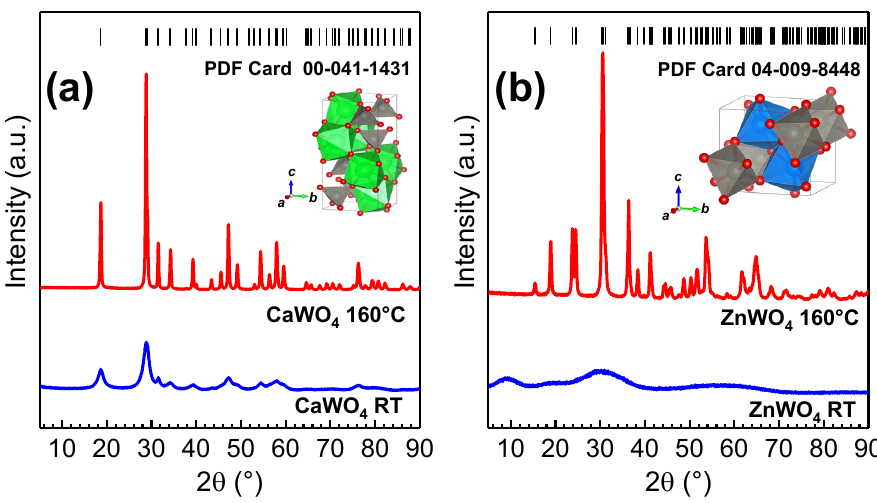
Figure 2. X-ray diffraction patterns of CaWO 4 ( a ) and ZnWO 4 ( b ) nanoparticles left at RT ( bottom ) and treated at ∼ 160 °C for 24 h ( middle ). The standard PDF cards of the CaWO 4 (PDF Card 00-041- 1431) and ZnWO 4 (PDF Card 04-009-8448) phases are shown for comparison at the ( top ). The crystal structures of the tungstates are shown in the